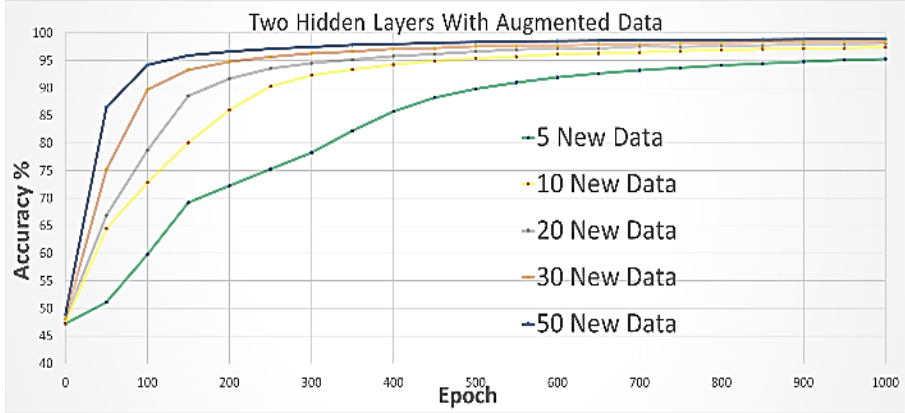
Figure 6. Training with two hidden layers with augmented